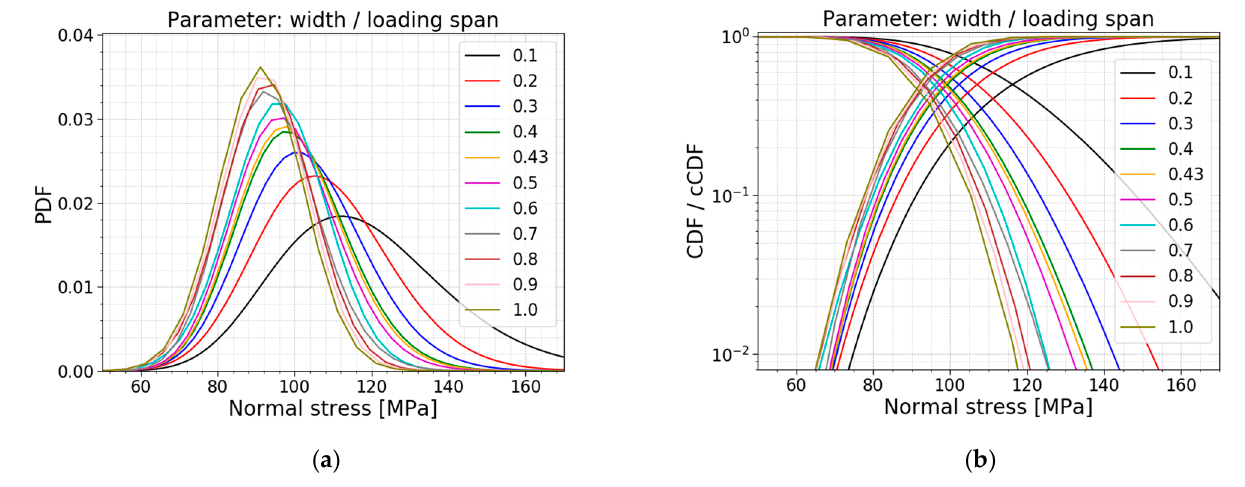
Figure 17. ( a ) PDF and ( b ) CDF for a varying ratio of the width to the loading span.